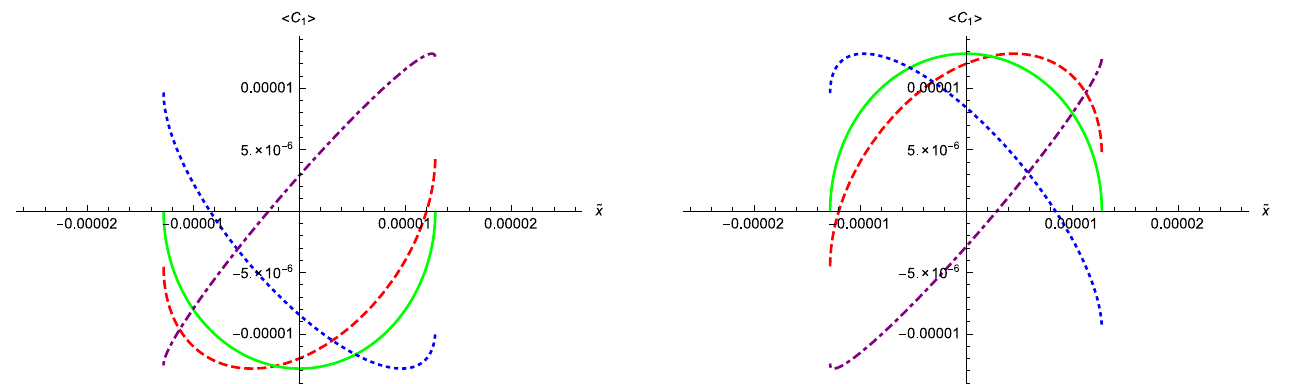
Figure 5. (cid:104) ˆ C 1 (cid:105) ( − ) (left) and (cid:104) ˆ C 1 (cid:105) (+) (right) for evolution parameters φ = 0.2 (dashed), φ = 0.26 (solid), φ = 0.4 (dotted), φ = 1